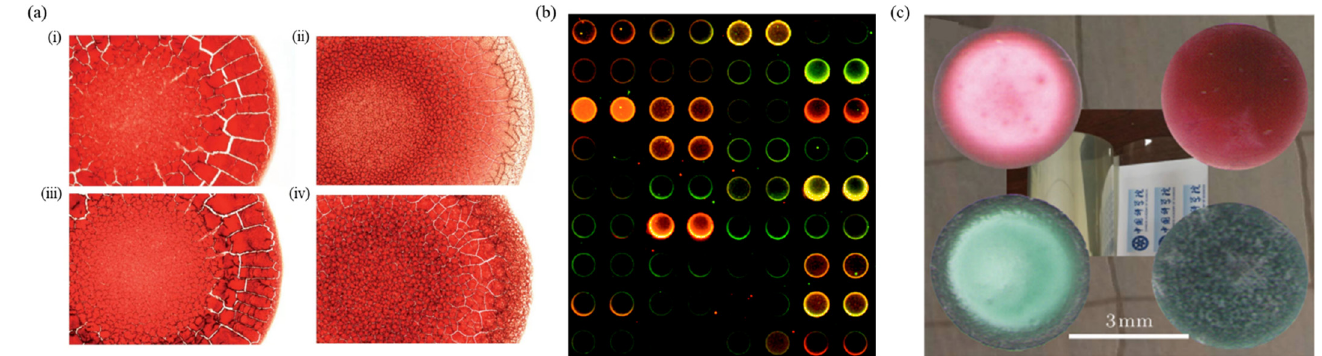
Figure 9. ( a ) Dried drops of blood (drop diameter: 5.9 mm) in (i) sample from a 27-year-old woman in good health, (ii) person with anemia, (iii) sample from a 31-year-old man in good health and (iv) person with hyperlipidemia (reproduced with permission from ref. [155]. Copyright 2010 Cambridge University Press). ( b ) Non-uniform deposition patterns in cDNA microarray (reproduced with permission from ref. [166]. Copyright 2002 American Chemical Society). ( c ) Photographs of patterns on a PET film after evaporation of drops of mixtures of acid red 1 (upper) and acid blue 25 (lower) solutions with 0 mM (left) and 16.0 mM (right) NaCl, respectively (reproduced with permission from ref. [67]. Copyright 2020 Chinese Physical Society and IOP Publishing Ltd.).